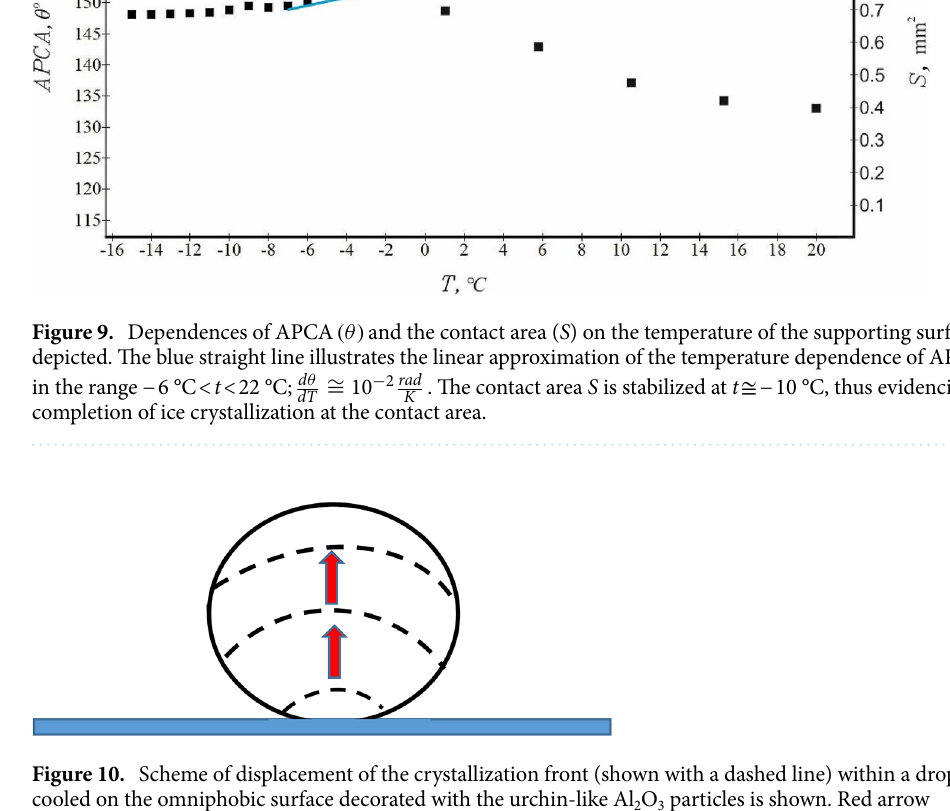
Figure 10. Scheme of displacement of the crystallization front (shown with a dashed line) within a droplet cooled on the omniphobic surface decorated with the urchin-like Al 2 O 3 particles is shown. Red arrow demonstrates the direction of the displacement of the crystallization front, the characteristic time of the displacement of the crystallization front within 5–10 μl droplet is estimated as 10–30